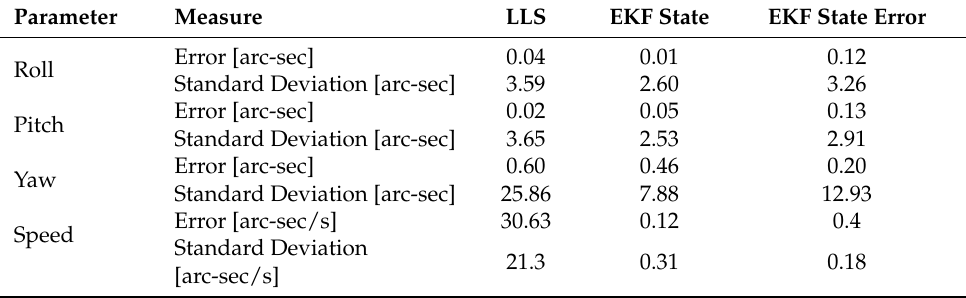
Table 3. EKF results with the simulation using an angular speed of 36 arc-sec/s.